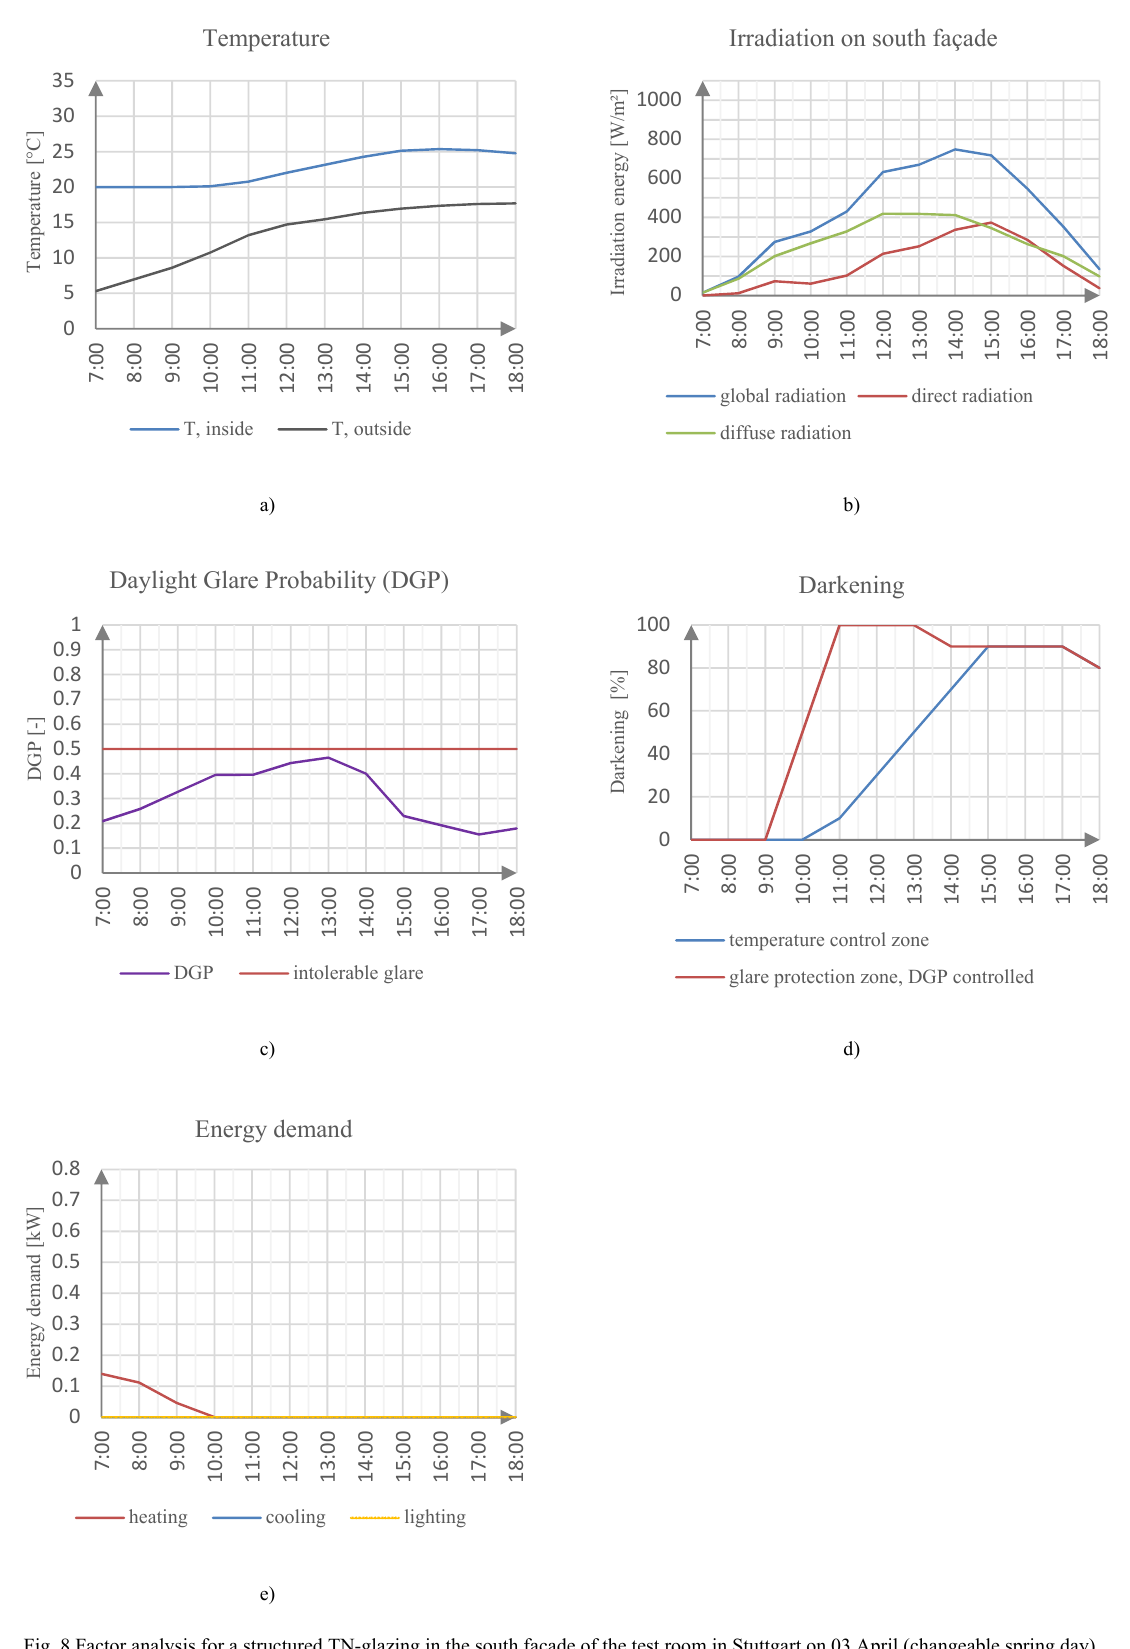
Fig. 8 Factor analysis for a structured TN-glazing in the south façade of the test room in Stuttgart on 03 April (changeable spring day) As apparent, because of low air temperatures in the early morning, a small amount of heating energy is needed to provide the minimal indoor temperature of 20 °C. During the day the switching process of the TN-glazing takes control of the thermal comfort in the room. The main window part is darkened stepwise with the increasing temperature. In order to prevent glare from high solar irradiation about noon the glare protection zone